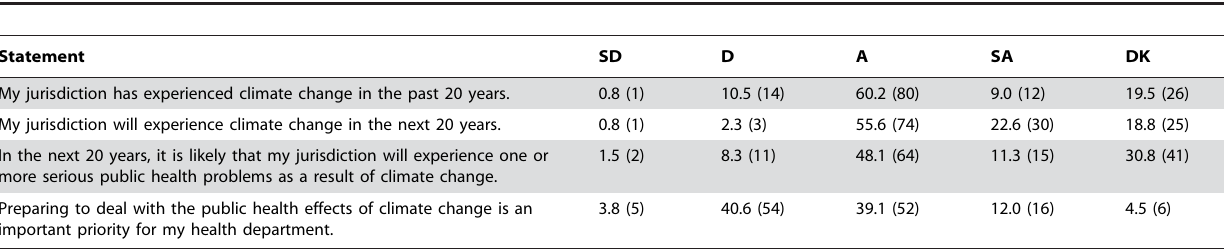
Table 1. Local health department director’s perceptions about general climate change impacts and its